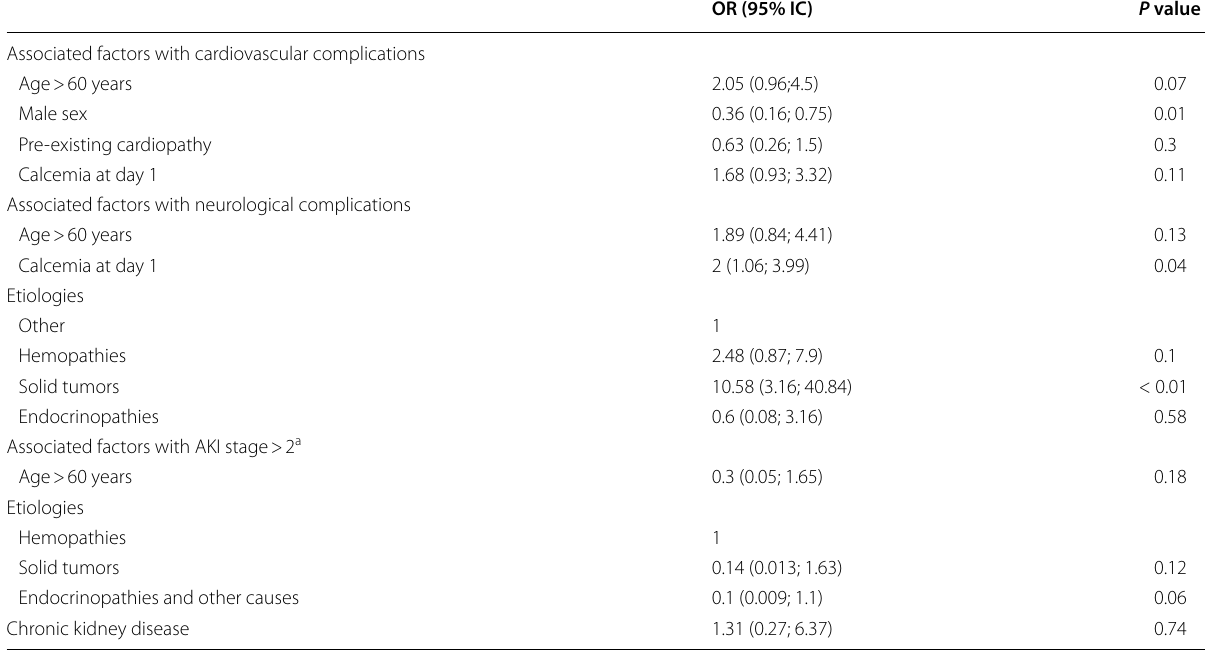
a Three patients were excluded due to pre-existing renal replacement therapy AKI acute kidney